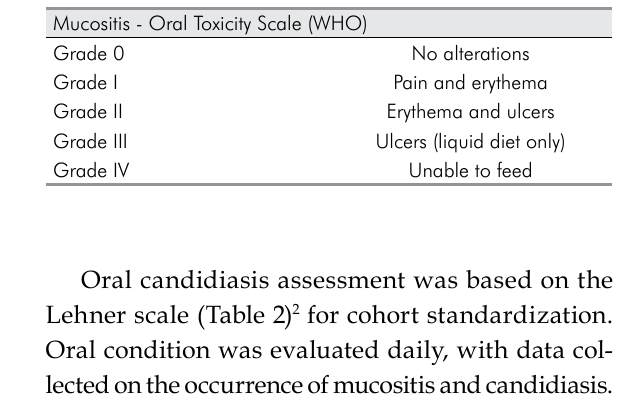
table 1. World Health Organization Oral Mucositis Classification